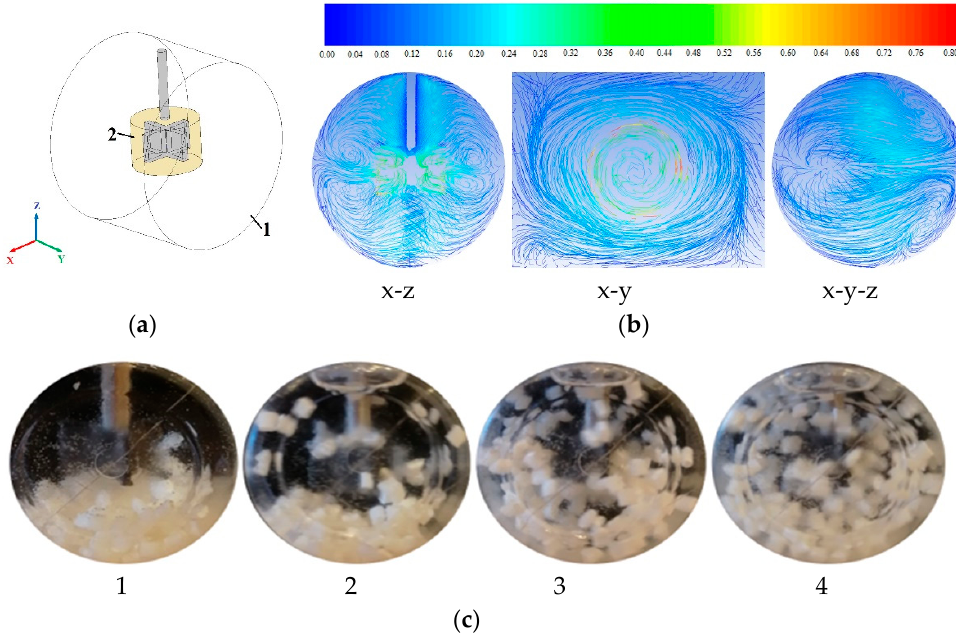
Figure 4. Mixing analysis. ( a ) Simulation model of mixing process (with a coordinate system): 1: internal volume of the reactor (the first zone of the model), 2: impeller zone (the second zone of the model); ( b ) Velocity vectors in different planes; ( c ) Experimental results of mixing process: 1-the mixing process is not running, 2: 0.5 s after the start of mixing, 3: 1 s after the start of mixing, 4: 1.5 s after the start of mixing.